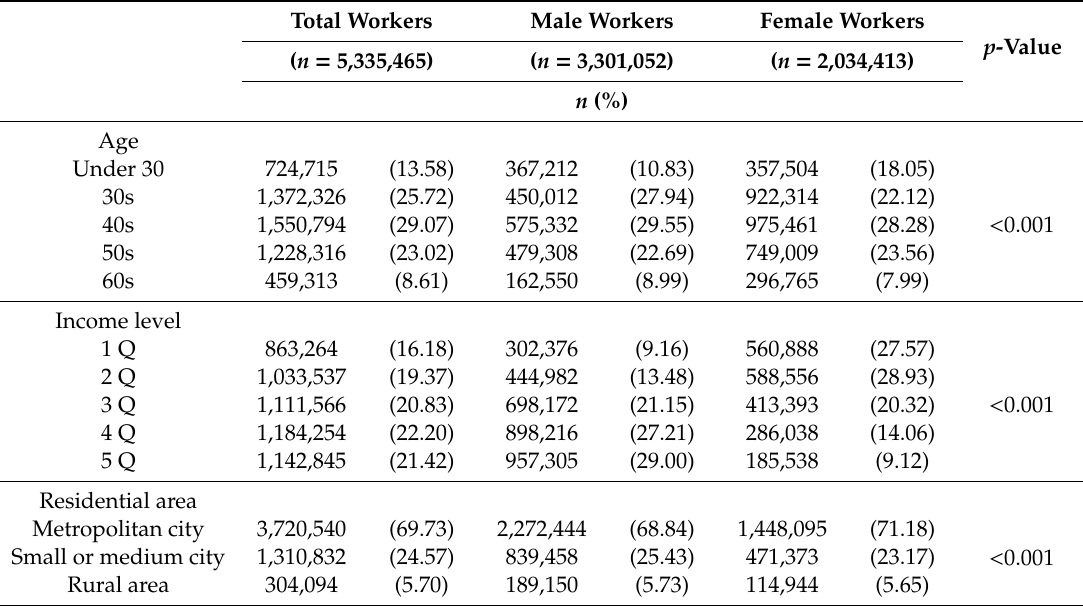
Table 1. Baseline characteristics of this study cases by sex ( n = 5,335,465). Total Workers Male